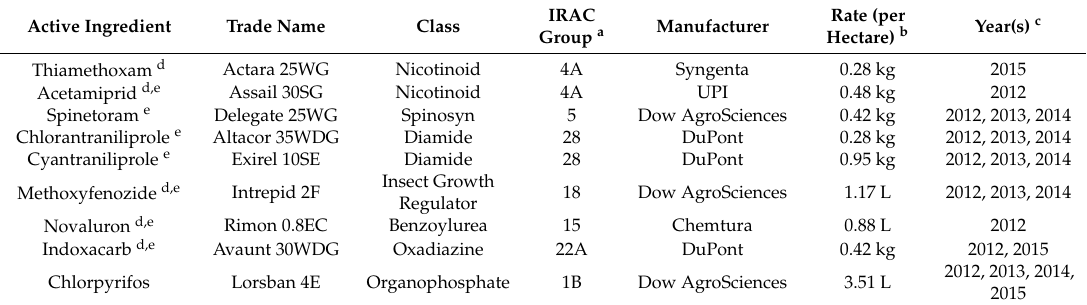
Table 1. List of insecticide names, classes, and rates used in laboratory and extended laboratory